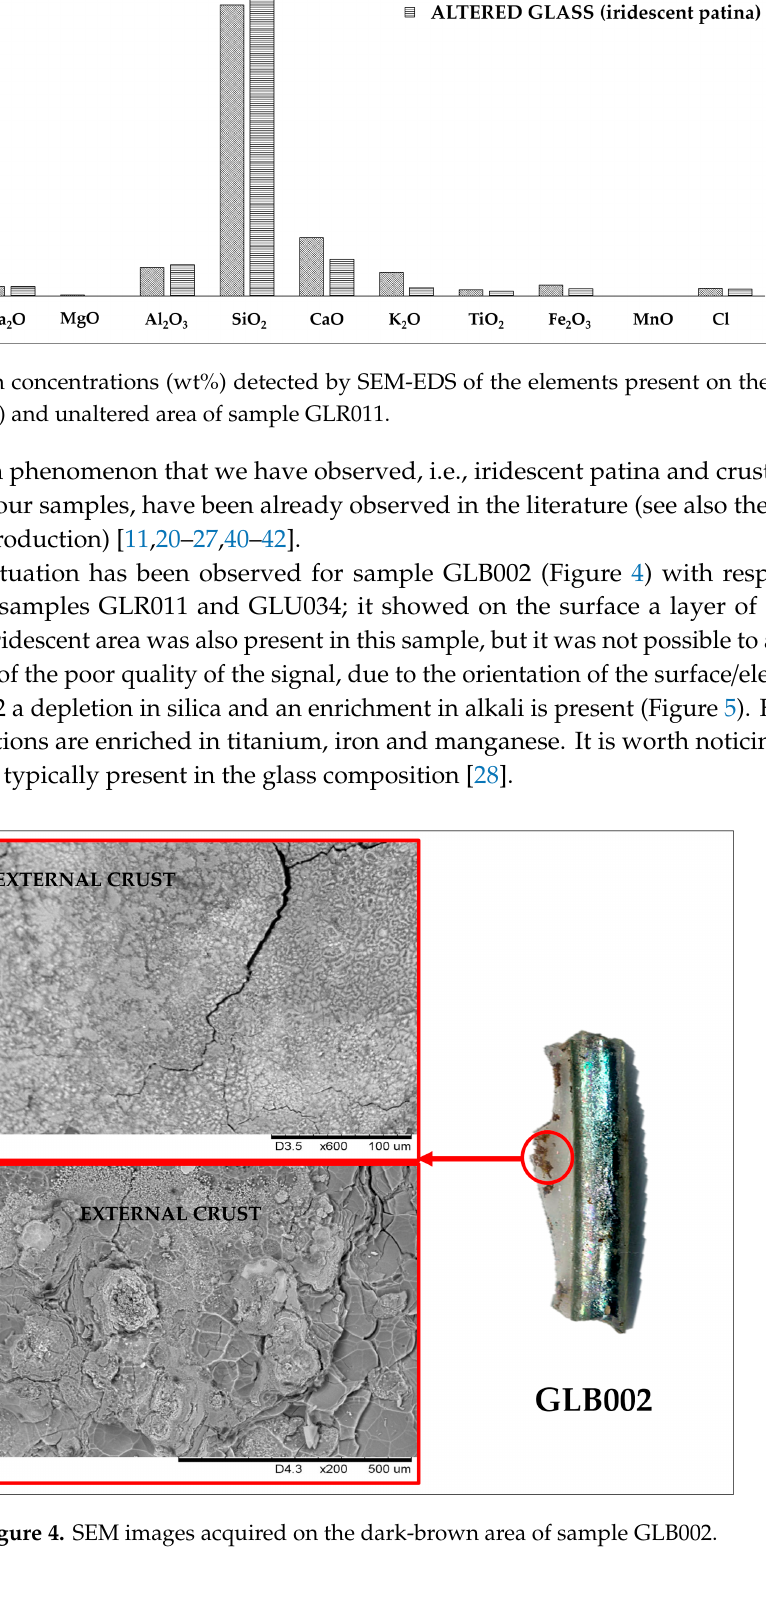
Figure 2. SEM images acquired on the iridescent surface of GLU034 and GLR011 samples.